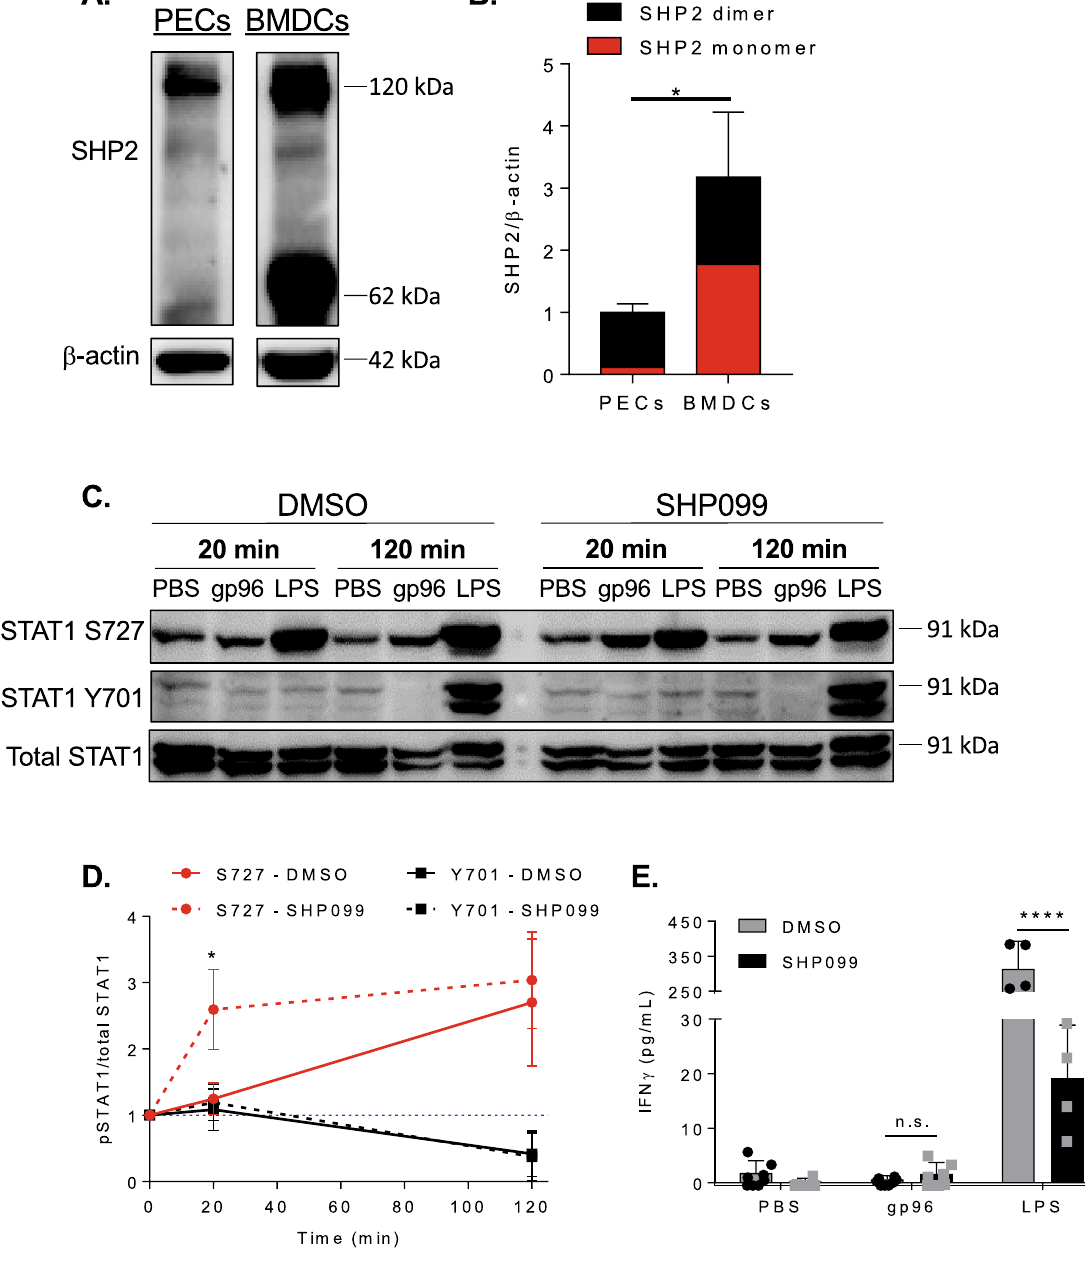
Figure 6. SHP2 limits STAT1 phosphorylation in DCs. (A and B) Cell lysates from PECs or BMDCs were immunoblotted for SHP2. (A) One representative immunoblot of 3 independent experiments is shown. Both PEC and BMDC samples were run on the same blot and developed together. (B) Pooled data from 3 independent experiments is shown. * indicates significance between PECs and BMDCs in the amount of monomer present. (C and D) BMDCs were pre-treated for 3 h with SHP099 then activated with 200 µ g/mL gp96 or 1 µ g LPS for 20 or 120 min. Cell lysates were immunoblotted for phospho-STAT1 S727 or Y701 and total STAT1. (C) One representative immunoblot of 3 independent experiments is shown. (D) Pooled data from 3 independent experiments is shown. * indicates significant difference in S727 phosphorylation between DMSO and SHP099 treated cells. (E) Fifty thousand PECs were plated with 5 × 10 4 NK cells in the presence of 200 µ g/ mL gp96 and SHP099. Supernatant was harvested after 72 h and assayed by IFN- γ ELISA. Data is pooled from 3 independent experiments. Data are represented as mean ± s.d. *p < 0.05, **p < 0.01, ***p < 0.001 (Two-way ANOVA with Sidak’s multiple comparison